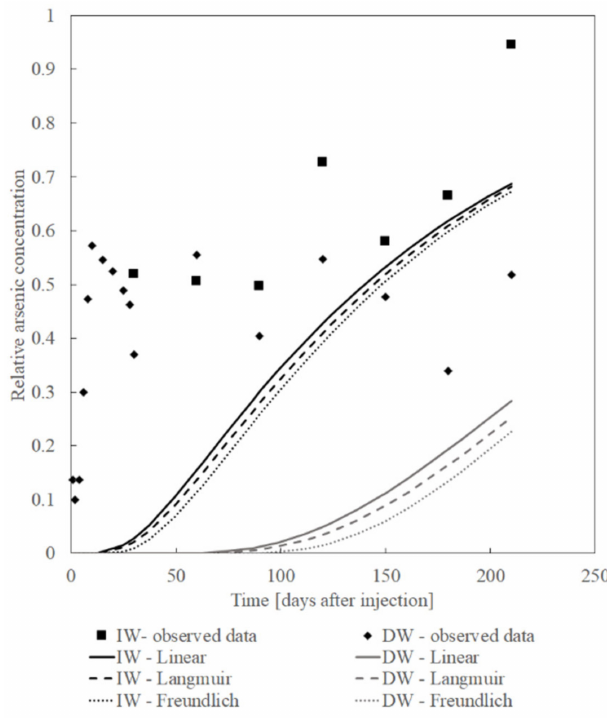
Figure 4. Comparison between observed arsenic concentrations at the injection (IW, black) and downstream (DW, grey) wells of the pilot site for different adsorption isotherms based on kinetic parameters from the column data (lines). The data points show the observed arsenic concentrations during field